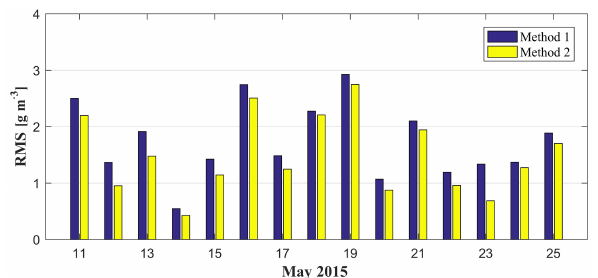
Figure 7. The rms comparison of the tomographic result derived from two methods with radiosonde data during the experimental period.